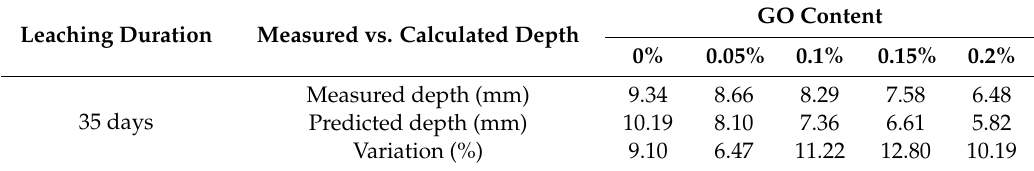
Table 7. Comparisons of measured results and predicted results for compressive strength loss (%). Leaching Duration Measured vs. Calculated